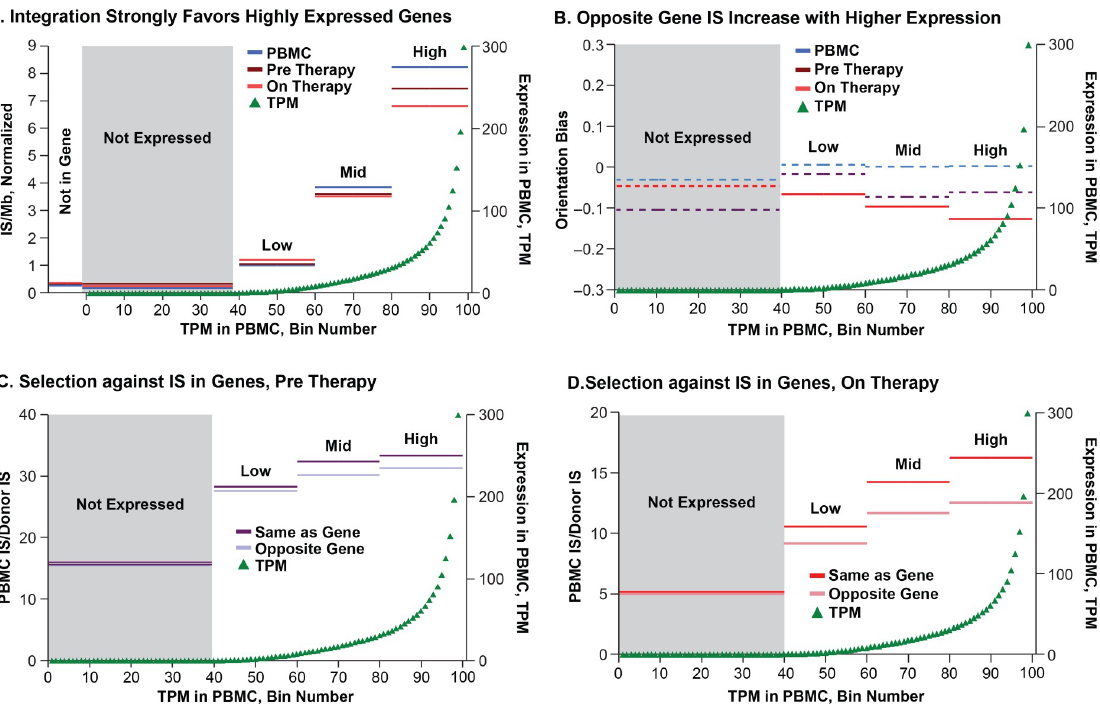
Fig 1. Gene expression and integration. The complete set of ca 22,000 RefSeq genes was slightly modified to remove overlaps (see Methods). The non-overlapping genes were divided into either 100 bins or 4 bins, based on transcripts per million reads (TPM) obtained from the RNA-seq analysis of the in vitro infected PBMC. The 100-bin RNA-seq data are shown in green triangles in all panels. The combined IS data are shown for the genes in each of the 4 bins in all panels for PBMC (blue), pre-ART donors (plum) and on-ART donors (red). Darker colors in C and D indicate proviruses oriented in the same direction as the host gene; lighter colors are in the opposite orientation. A . Total integration site (IS) density (sites/Mb) in each bin, normalized to the average for the whole genome (125 sites/Mb for PBMC, 4.28 sites/Mb pre-ART, and 10.7 sites/Mb on-ART). B . The orientation of the proviruses relative to the host gene was calculated for each bin as (proviruses oriented the same as the gene-proviruses opposite the gene)/(total proviruses). Dashed lines indicate p values (binomial) > 0.05. C and D . Ratios of proviruses per bin for the pre-ART ( C ) or on-ART ( D ) samples. Note that the higher the ratio, the smaller the number of IS in the donor samples relative to the in vitro infected PBMC samples. S1 Fig shows the same results with the 100-bin IS data